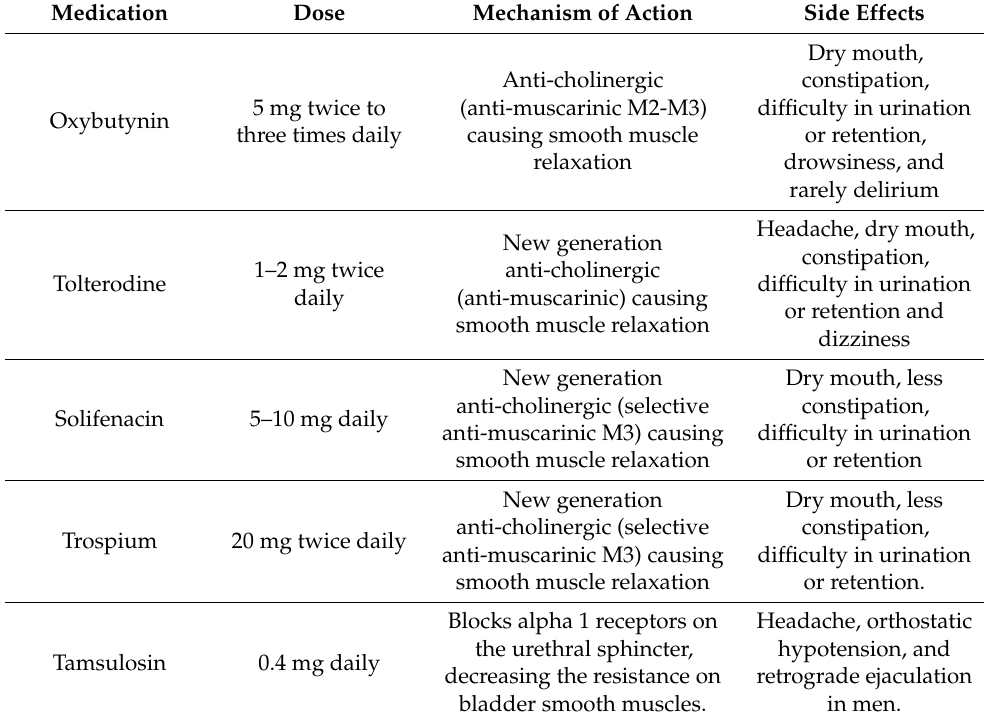
Table 1. Medications used for the management of lower urinary tract symptoms/bladder dysfunction.